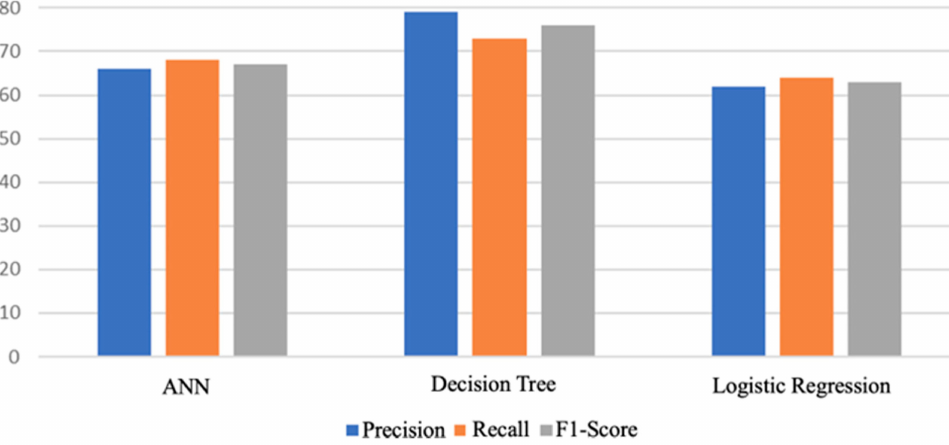
Figure 11. Comparison of Metrics for Class “0”